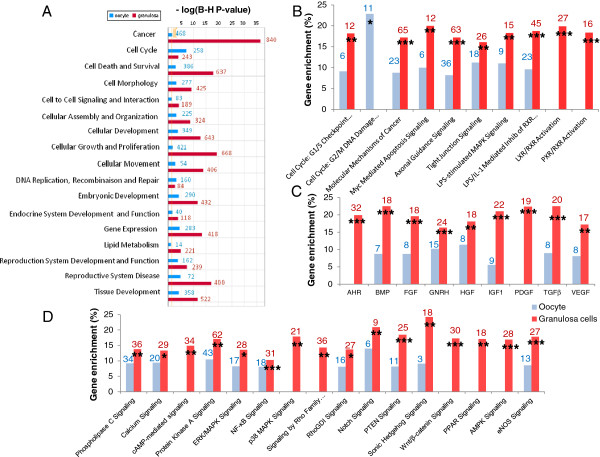
Functional enrichment and canonical pathways within oocyte and GCs. A: Functional enrichment. Genes differentially expressed between the 2 compartments were evaluated in silico using Ingenuity Pathway Analysis (IPA). The figure shows the most significant functional groups (p < 0.05, FDR < 5%). For each compartment, the gene list corresponds to up regulated genes compared to the other compartments. The bars represent the p-value at logarithmic scale. GC data are in red and oocyte data are in blue. Red and blue numbers correspond to the number of focus genes that contributed to the function concerned. B: Canonical pathways in oocytes and GCs. Significantly enriched canonical pathway categories (p-value < 0.05) identified in the 2 compartments. The Y axis corresponds to percentage gene enrichment in the pathway. Red and blue numbers correspond to the number of focus genes that contributed to the pathway concerned. *: FDR < 0.25 (likely to be valid 3 out of 4 times); **: FDR <0.10; ***: FDR < 0.05. C: Growth factor signaling pathways in oocytes and GCs. Significantly enriched growth factor signaling pathways (p-value < 0.05) identified in the 2 compartments. The Y axis corresponds to percentage gene enrichment in the pathway. Red and blue numbers correspond to the number of focus genes that contributed to the pathway concerned. *: FDR < 0.25; **: FDR <0.10; ***: FDR < 0.05. D: Signaling pathway in oocytes and GCs. Significantly enriched signaling pathways (p-value < 0.05) identified in the 2 compartments. The Y axis corresponds to percentage gene enrichment in the pathway. Red and blue numbers correspond to the number of focus genes that contributed to the pathway concerned. *: FDR < 0.25; **: FDR <0.10; ***: FDR < 0.05.